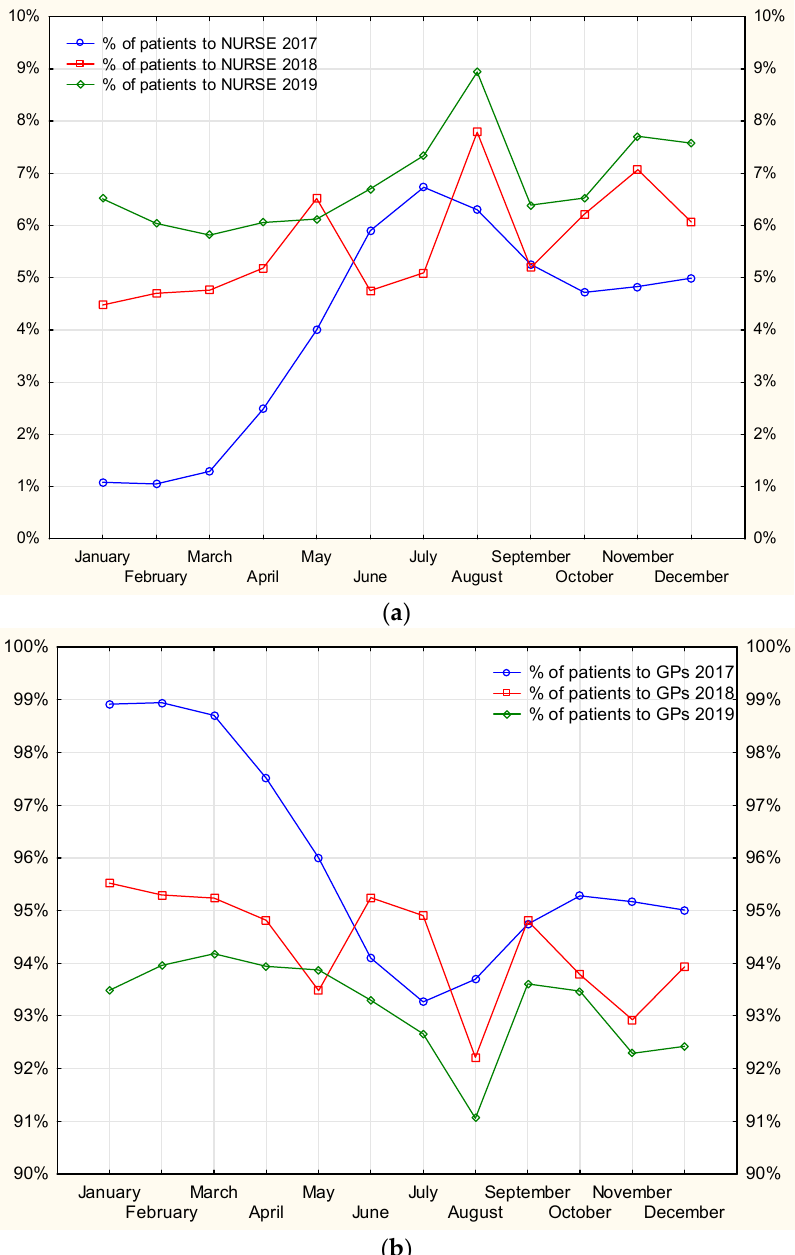
Figure 11. Percentage of patients visiting the nurse ( a ) and GP in each of the analyzed years separately ( b ).